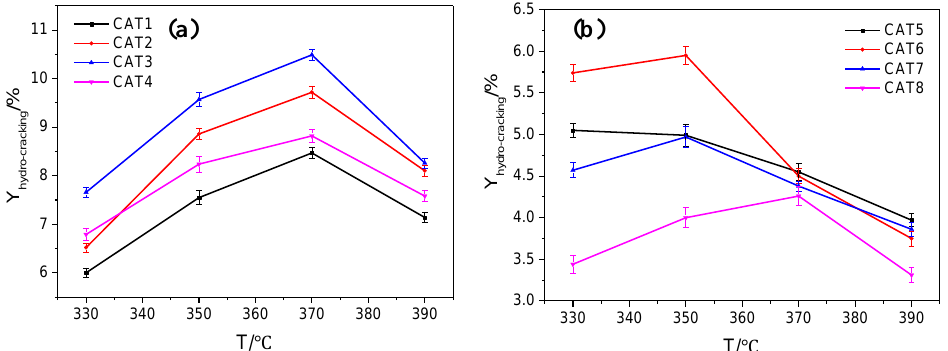
Figure 10. The relationship between yields of Y hydro − cracking and temperature over catalysts ( a ) CAT1–CAT4 and ( b ) CAT5–CAT8.